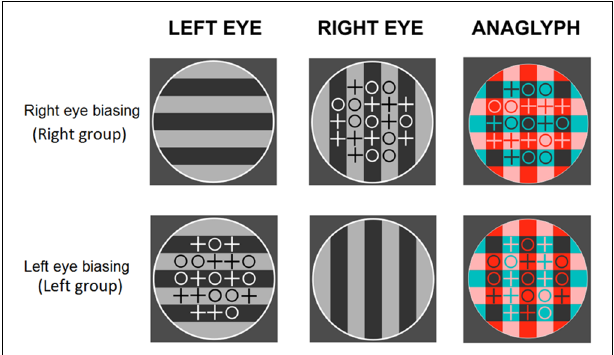
FIGURE 7 | Experiment 3. Examples of stimuli during the counting task. Anaglyphs for the right- (upper row) and left-attended (lower row) groups. The control group saw both type of displays in different